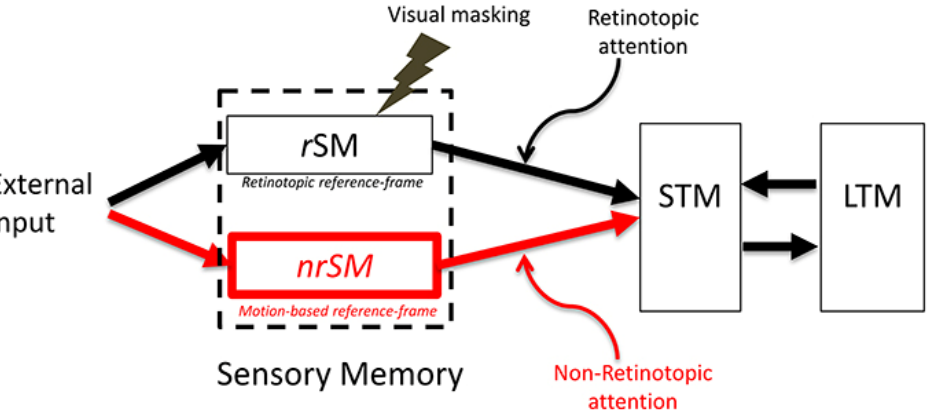
Figure 2. The modified SM model. In addition to the traditional retinotopic SM ( r SM) in the Atkin- son–Shiffrin model, a second non-retinotopic component, nr SM is added. From Ref. [3].